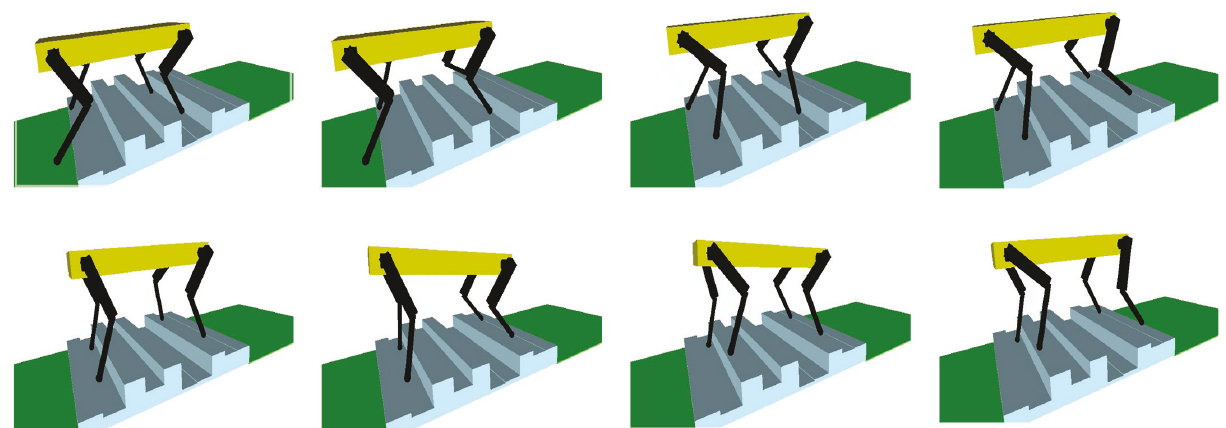
Figure 9: Series of standard static gaits for two circles on structured terrain.